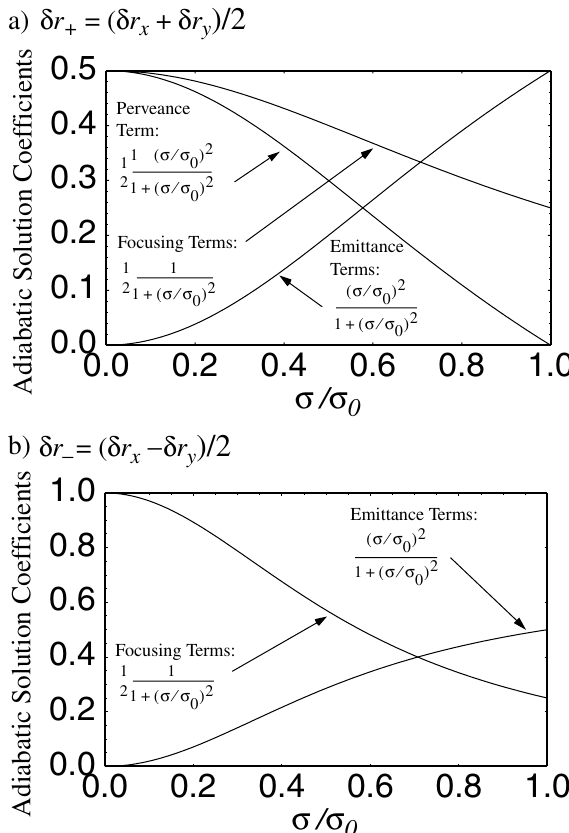
FIG. 8. Coefficients in Eq. (68) describing the strength of adiabatic limit envelope response terms to classes of driving perturbations are plotted as a function of (cid:24)=(cid:24) occurring in the sum ( r (cid:5) ) and difference ( r (cid:2) ) particular solutions are plotted separately in (a) and (b).